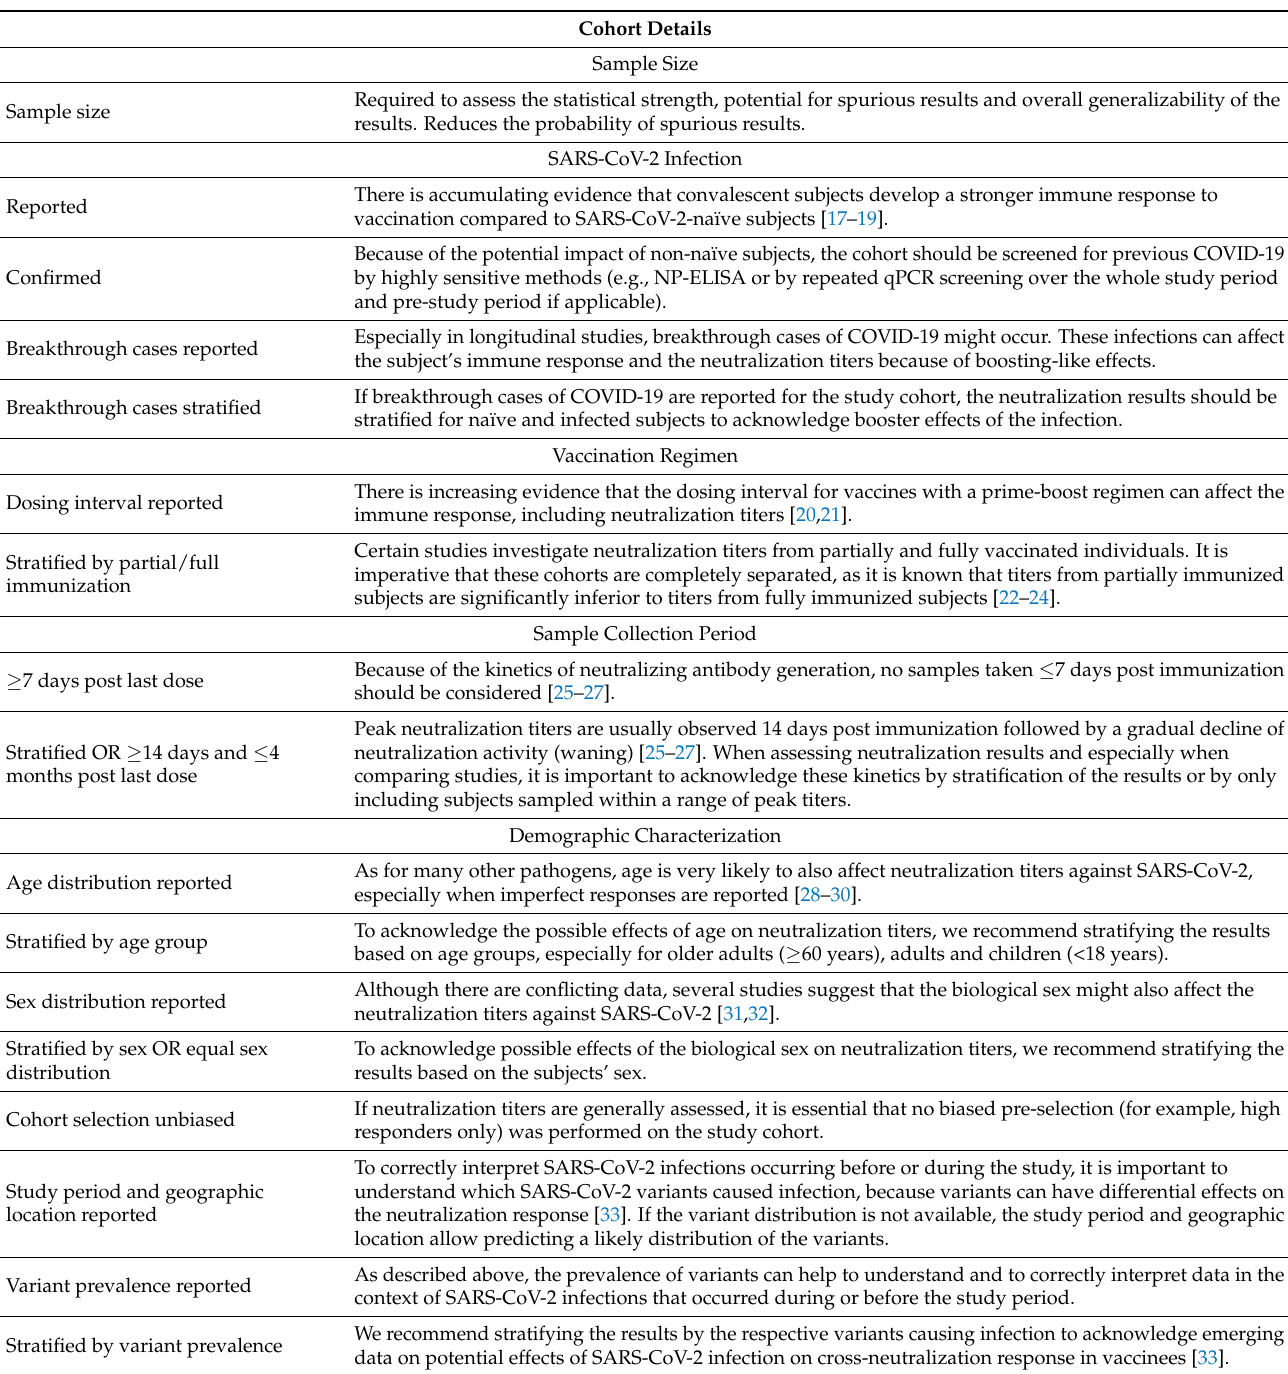
Table 1. Aspects and parameters that are associated with possible risks of low reliability for studies assessing post-vaccination neutralization against